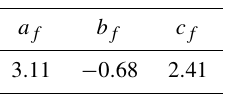
Table 3. Fitted parameters: super-Gaussian order n